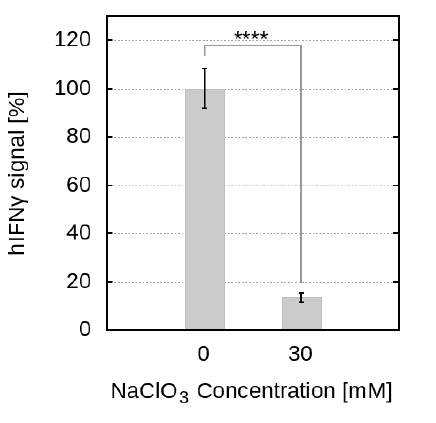
Figure 6. Effect of NaClO 3 on the hIFN γ signal. After subtraction of the blank value, the absorbance obtained from cells treated with hIFN γ and cultivated in a culture medium containing 30 mM NaClO 3 is related to that obtained from cells treated with hIFN γ only, taken as 100%. The figures shown are based on 10 independent experiments and are represented as mean ± standard error of the mean (error bars). **** p -value <